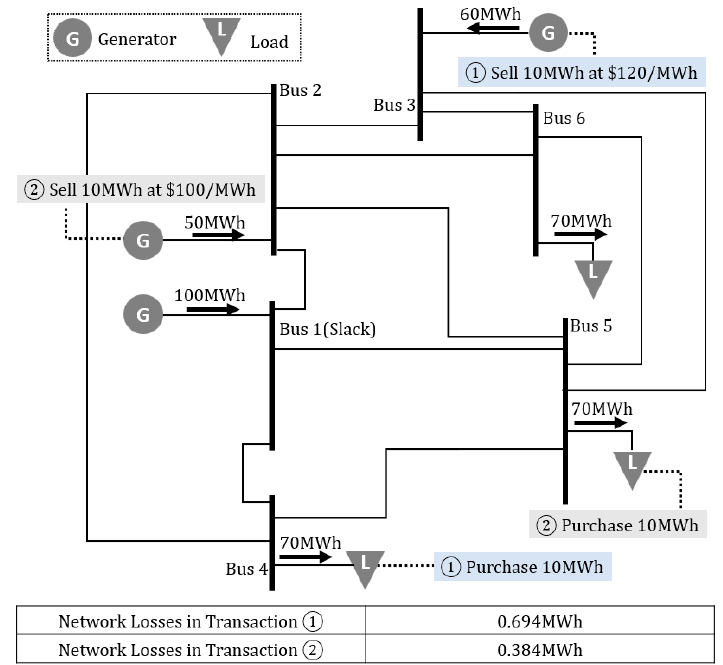
Figure 4. 6-bus network example of the price-guided trading framework.